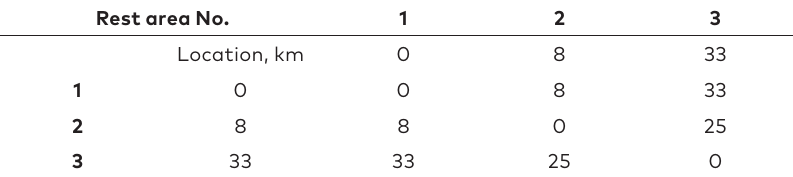
Table 3. Data on the distance between rest areas on the main road A3 Vilnius–Minsk (compiled by the authors, 2019) Rest area